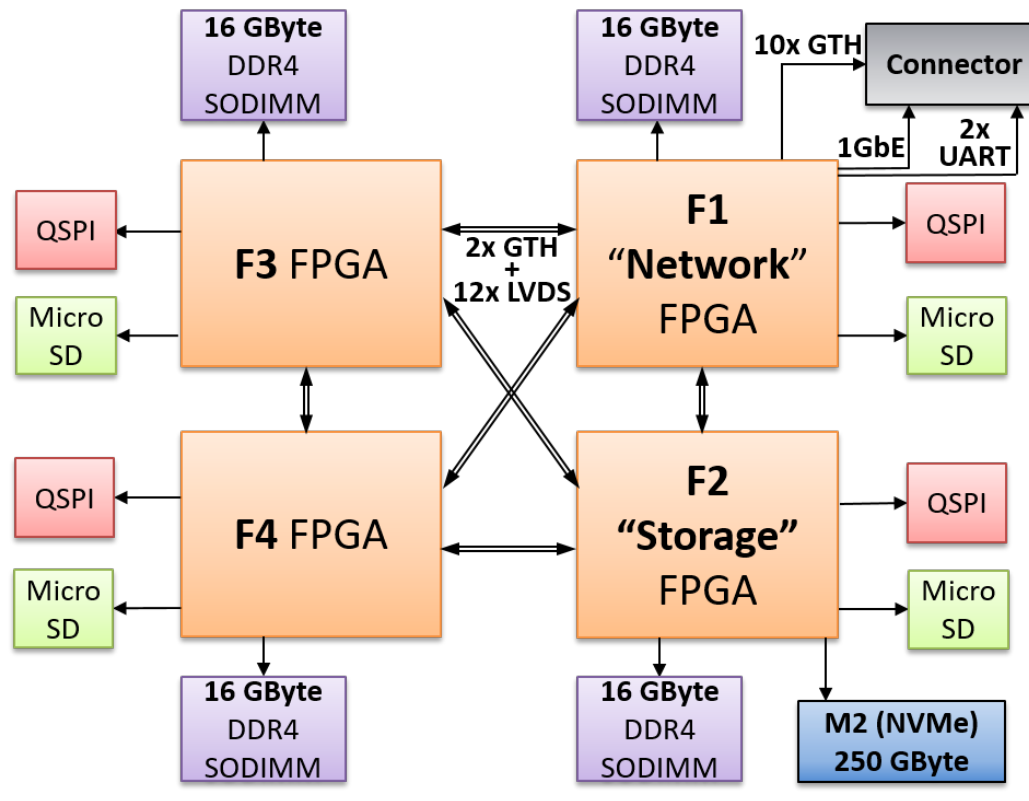
Figure 1. The Quad-FPGA daughterboard block diagram and